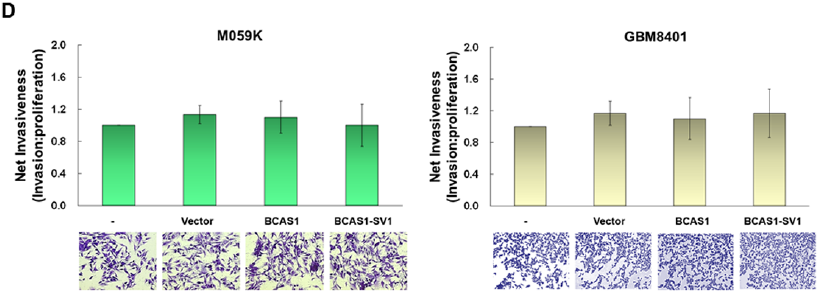
Figure 2. Characterization of M059K and GBM8401 cell lines stably expressing vector, BCAS1, and BCAS1-SV1, respectively. BCAS1-SV1 had a higher propensity to promote the proliferative and migratory but not invasive phenotype in GBM cells. ( A ) M059K (left) and GBM8401 (right) stable transfectants were analyzed for BCAS1 and BCAS1-SV1 expression by RT-PCR (top) and Western blotting (bottom). Primers were designed on exon 7 and exon 11 to obtain 479-bp (BCAS1) and 202-bp (BCAS1-SV1) products. Anti-BCAS1 and anti-myc antibodies were used to detect BCAS1 and BCAS1-SV1. β -actin was an internal control. ( B ) Cell proliferation of M059K (left) and GBM8401 (right) stable transfectants was determined by CellTiter Blue Cell Viability assay. ( C ) Cell migration of M059K (left) and GBM8401 (right) stable transfectants was determined by scratch wound assay. Bars, width of the initial scratch gap at the start of the experiment. A migratory index, Im, was defined as Im = (g0 − g12)/g0, where g12 and g0 are the gap widths at time 12 and time 0, respectively. ( D ) Invasion of M059K (left) and GBM8401 (right) cells was determined by InnoCyte cell invasion assay. After incubation for 24 h, the fluorescence in cells that had invaded the basement membrane was quantified (top) or stained with crystal violet